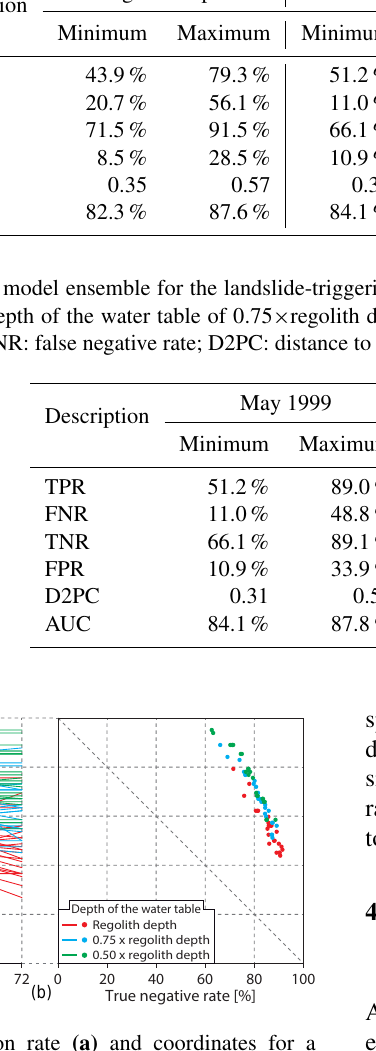
Figure 10. Temporal prediction rate (a) and coordinates for a FOS falling below 1.0 (b) , based on the model ensemble for the landslide-triggering rainfall event in May 1999. Three scenarios for the initial conditions (initial depth of the water table) are consid-